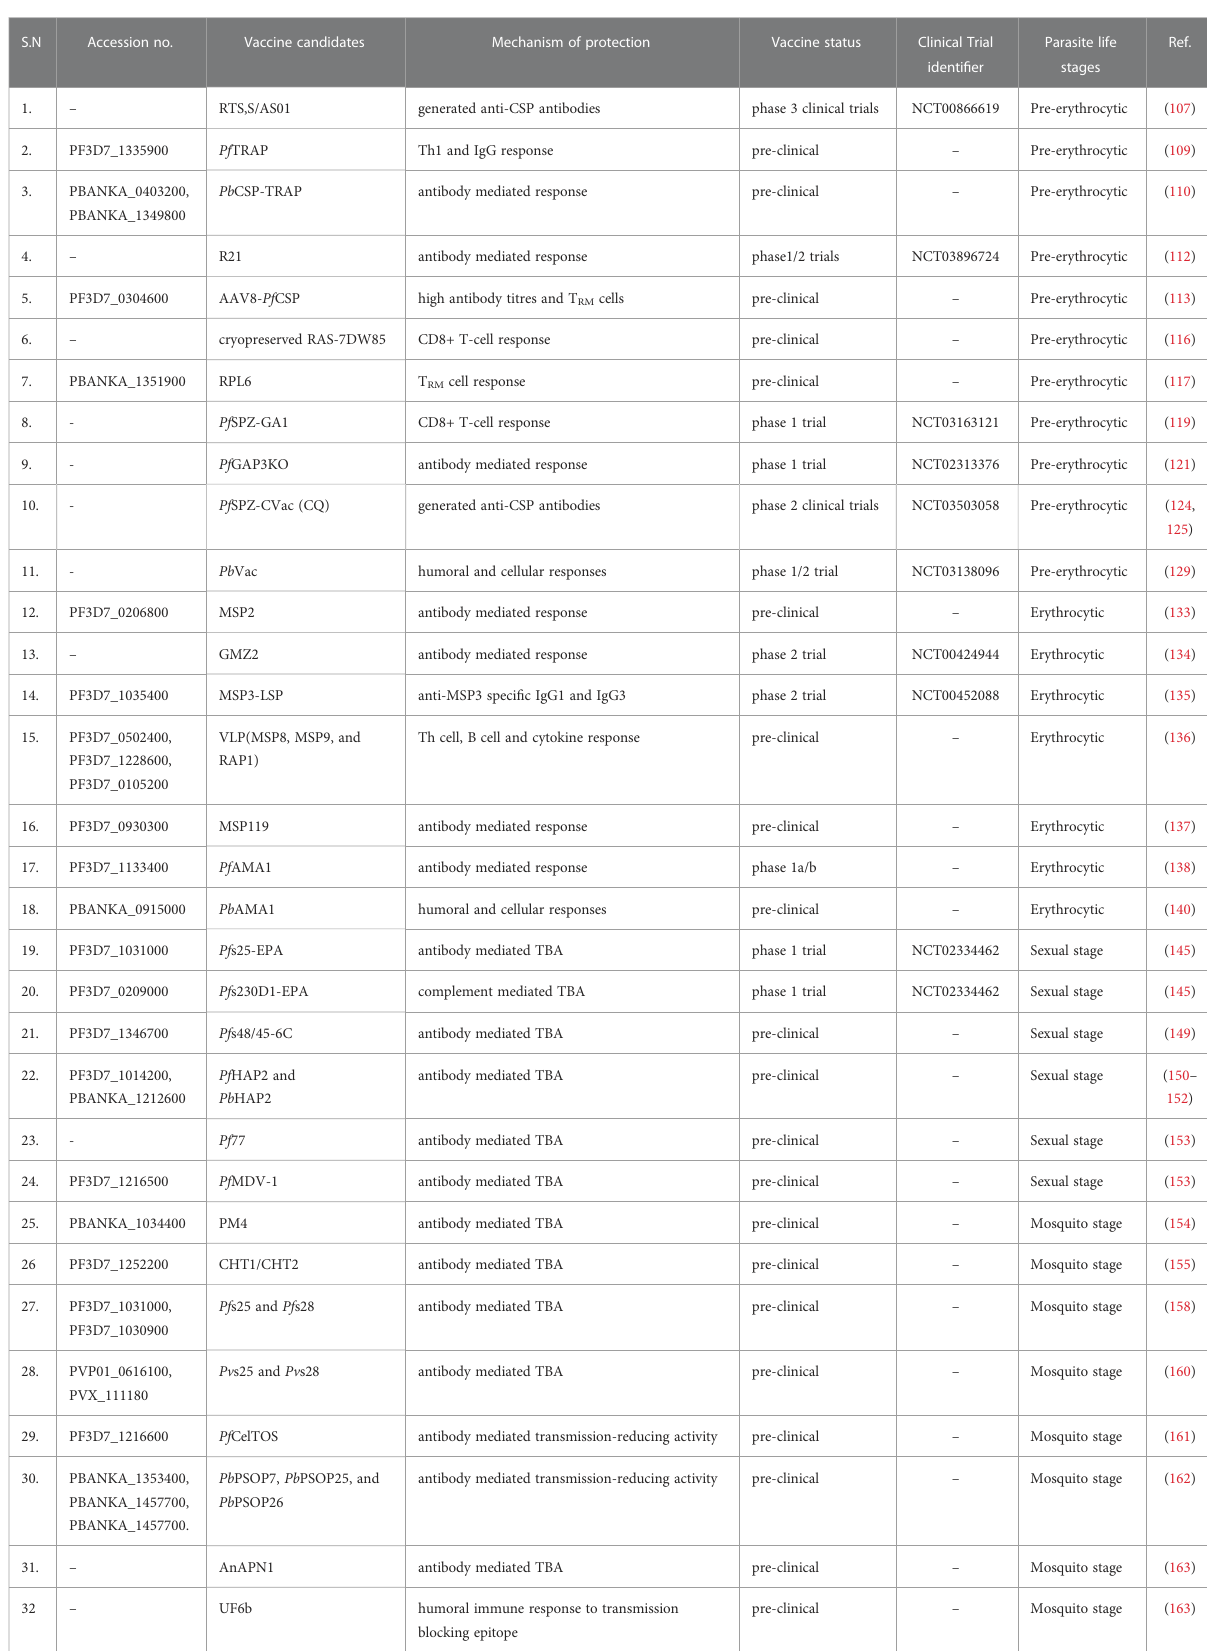
TABLE 2 List of vaccine candidates and their mechanisms of protection against malaria